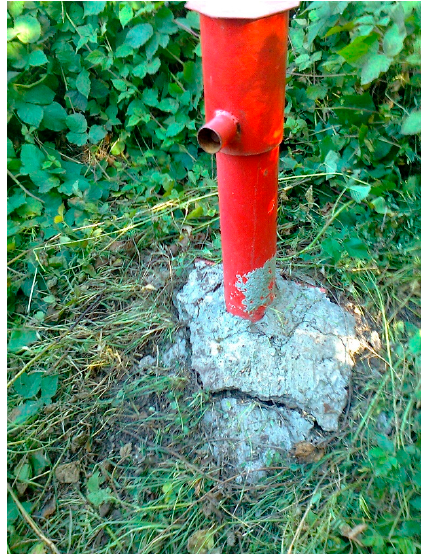
Figure 16. Combined outcomes of the methods used for detecting land subsidence / uplift in area no. 3. In order from left: the single-pair DInSAR and the PSI results (time series A and C) together with a graph of deformation of selected PS points from time series A, highlighted with a white background on maps. Remote Sens. 2019 , 11 , x FOR PEER